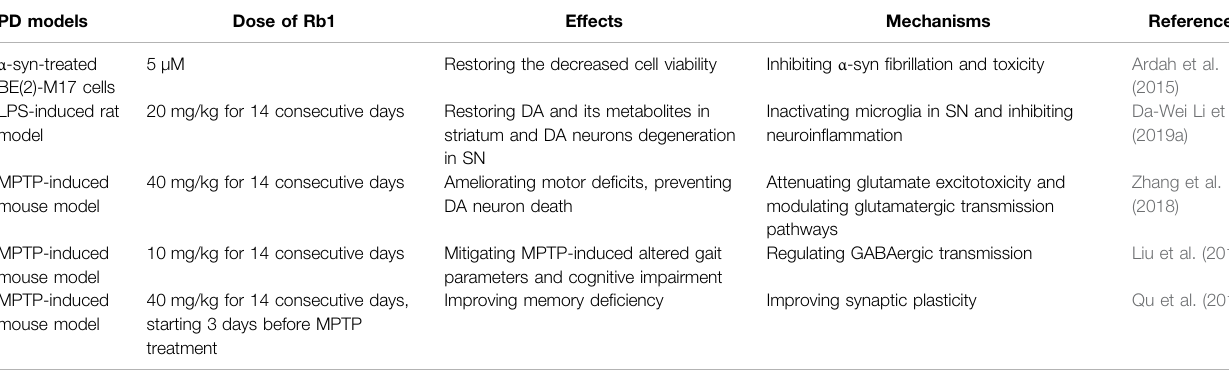
TABLE 2 | The neuroprotection of ginsenoside Rb1 in PD. PD